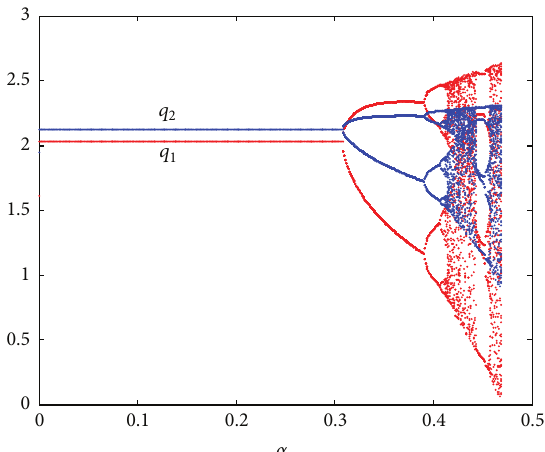
Figure 1: The bifurcation diagram of the system (13) with respect to the parameter 𝛼 .